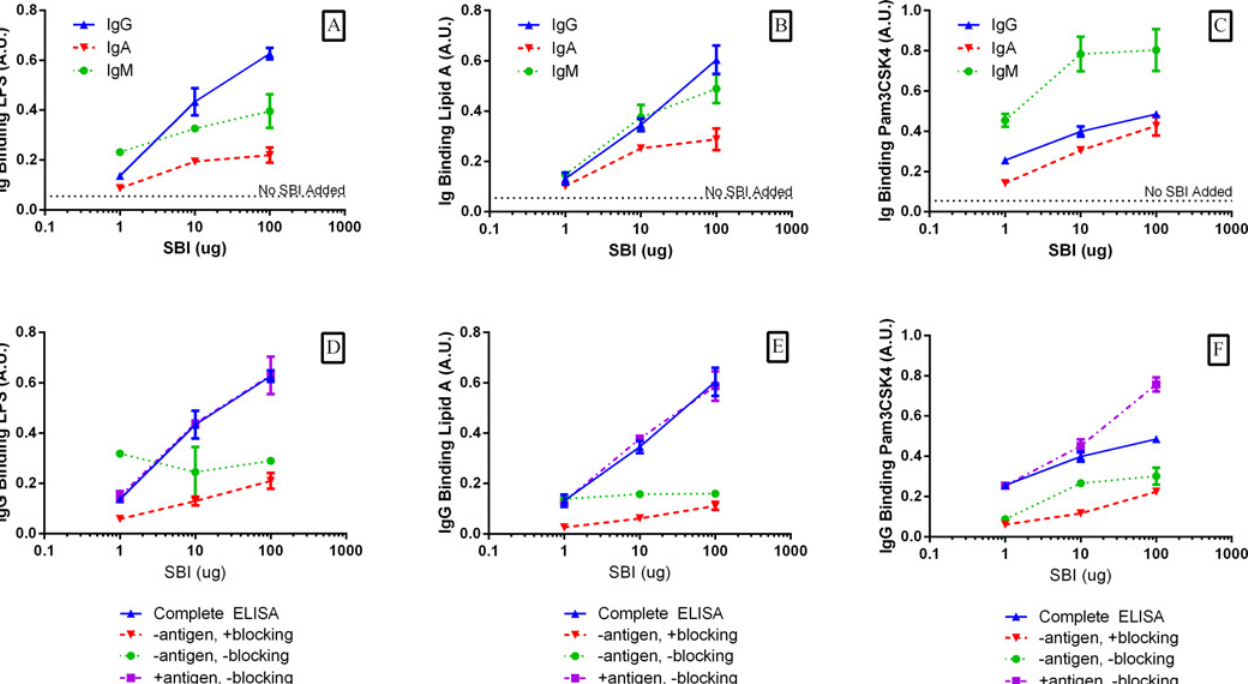
Fig 1. Binding Affinities of Immunoglobulins in SBI for Test Antigens. The binding affinities of bovine IgG, IgM, and IgA for LPS (Panel A), Lipid A (Panel B), and Pam3CSK4 (Panel C) were demonstrated using a modified ELISA technique. ELISA control conditions (D-F) confirmed IgG had a greater affinity for the antigens of interest (Complete ELISA) when compared with non-specific binding to blocking proteins (-antigen, +blocking) or the surface of the ELISA plate